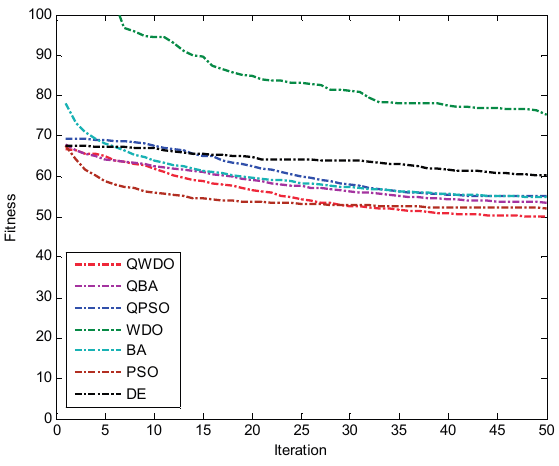
Figure 17. Result of the second instance for Maxgen = 250.